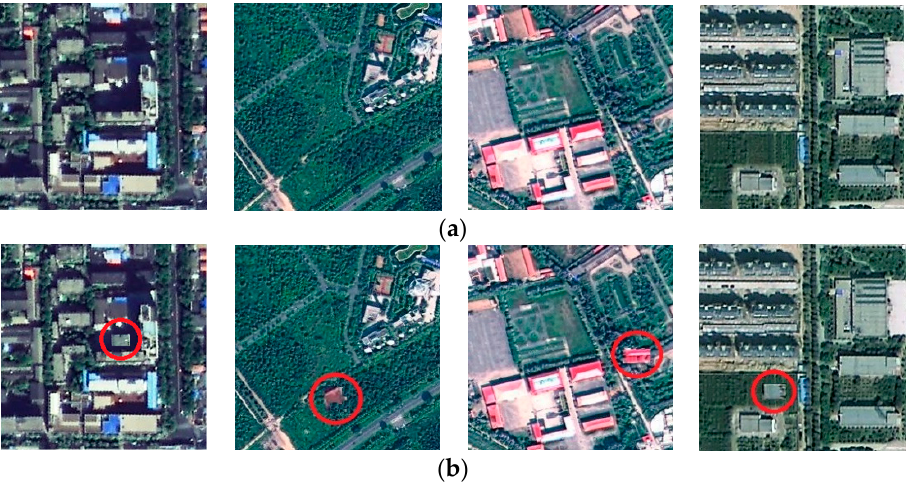
Figure 12. Tampering examples of appending object: ( a ) Original HRRS images, ( b ) corresponding tampered